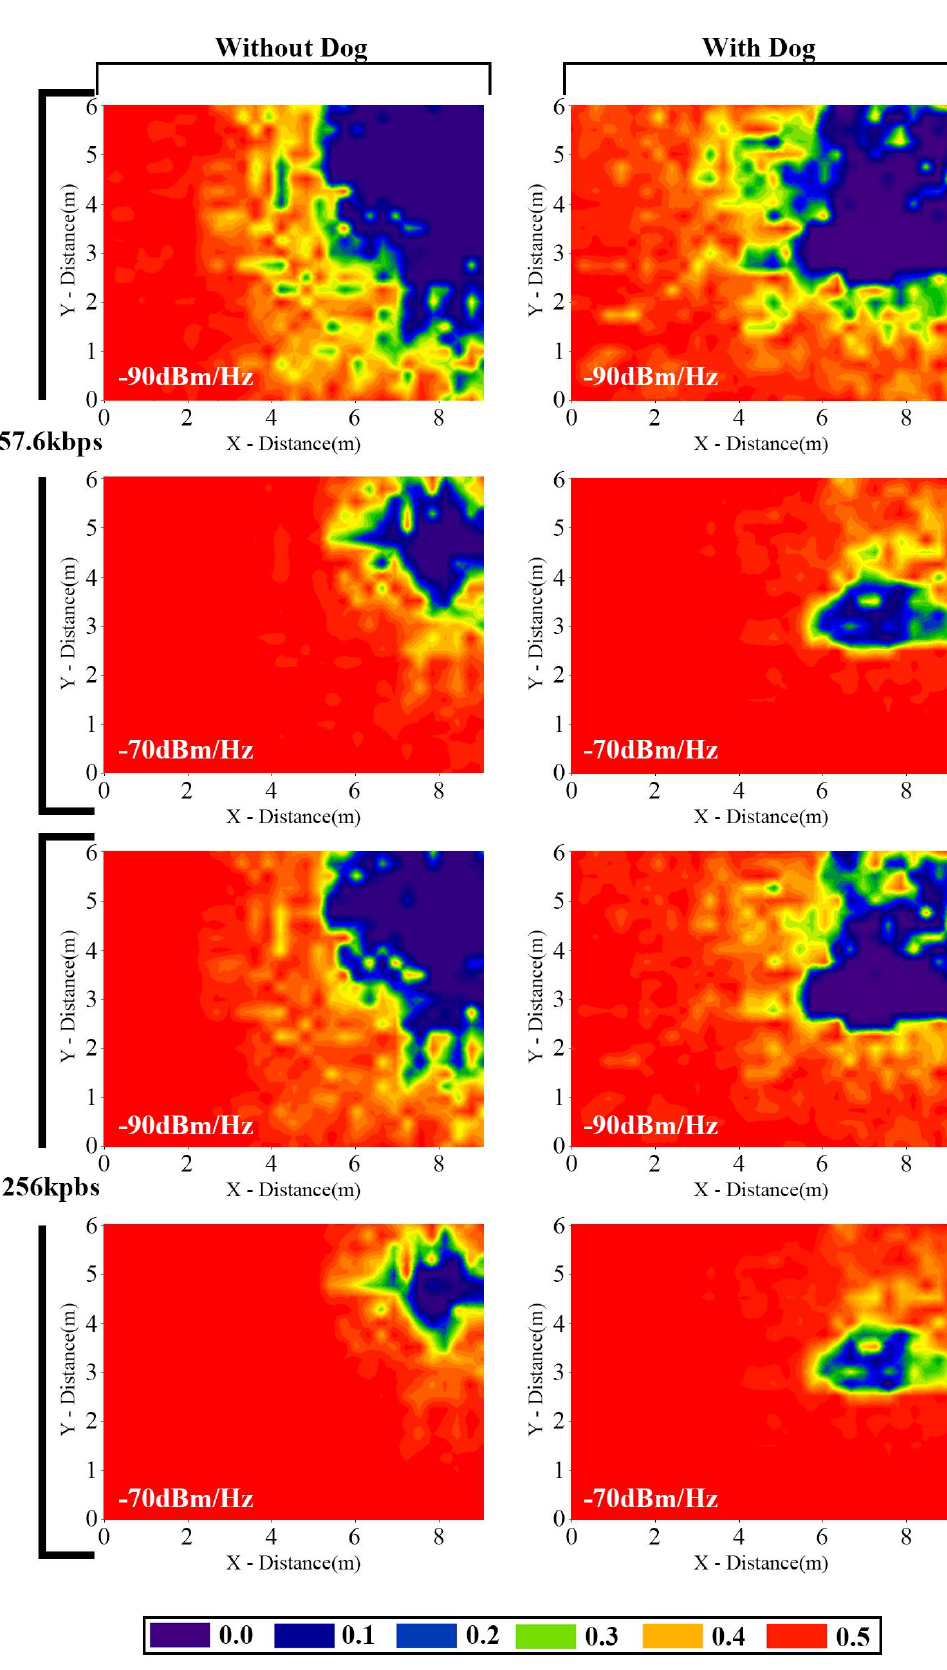
Figure 7. BER results considering different bit rates and noise levels for the antenna placed in the living room.